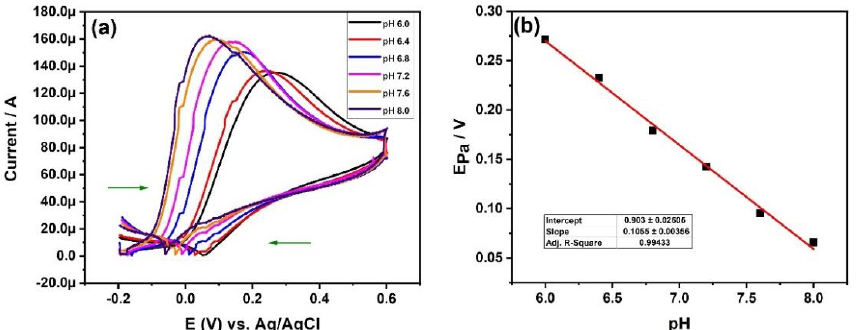
Figure 9. ( a ) Cyclic voltammogram of HEA-MCPE in 2 mM AA solution at different pH with a scan rate of 100 mVs − 1 . ( b ) Graph of pH vs. Epa at 2 mM AA.